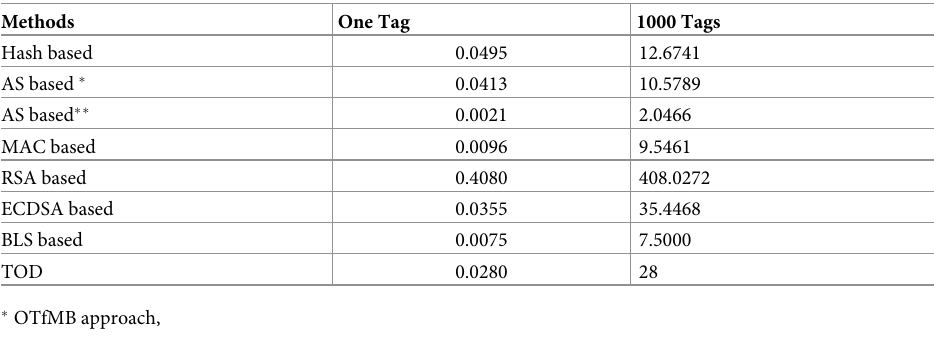
Table 10. Comparing the TOD method and the related works: The required time of tag generation (in seconds).